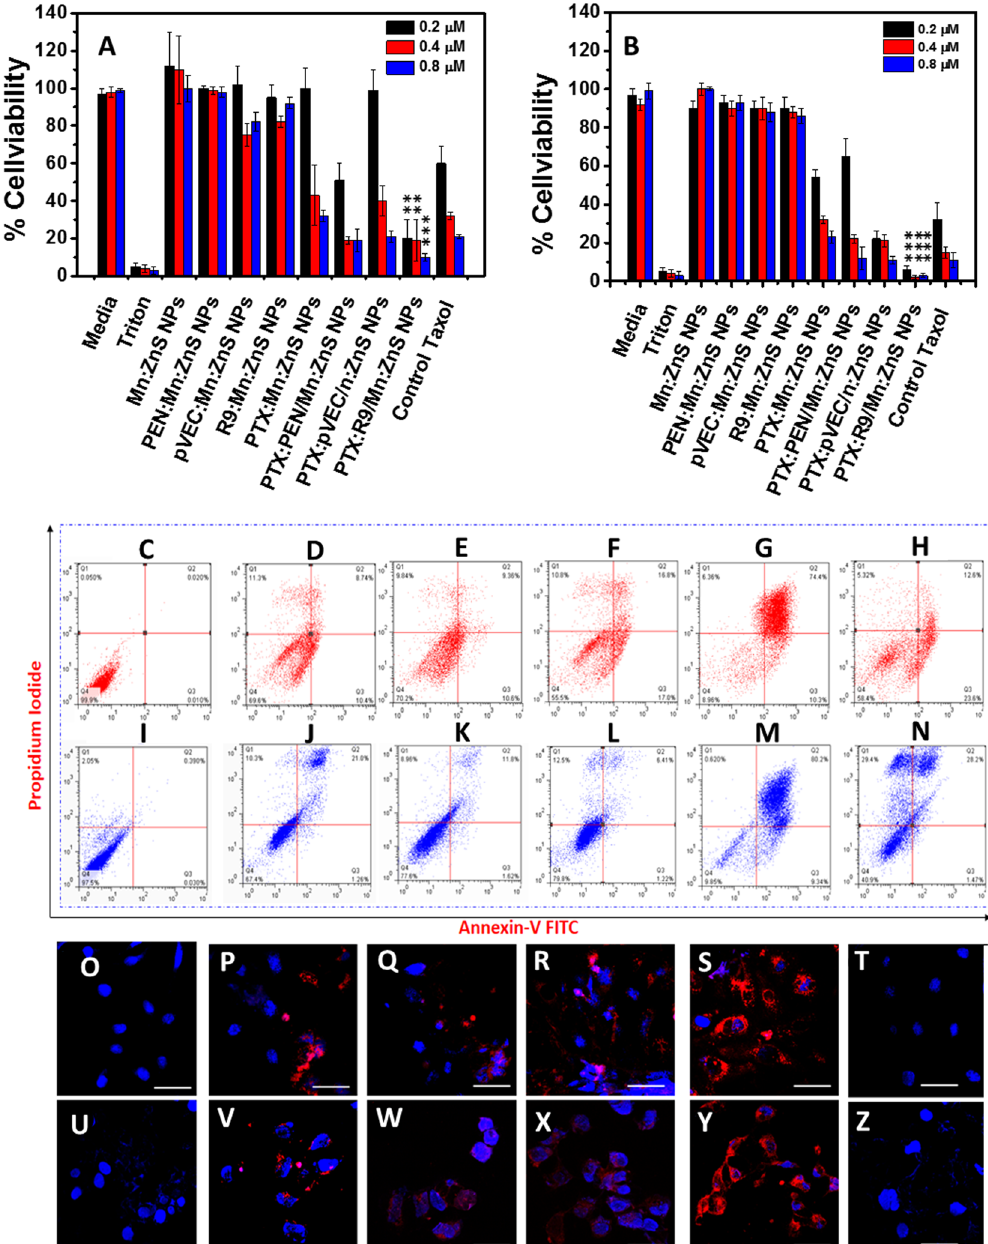
Figure 4. In vitro therapeutic efficacy assessment on ( A ) SKOV-3 and ( B ) HeLa cells by PTX-CPP modified Mn:ZnS NPs after 48 h incubation; The control vehicle concentration is 50, 100, and 200 µ g/mL, whereas the control PTX concentration is 10, 20 and 30 µ M. The actual PTX concentration in samples are 0.2, 0.4 and 0.8 µ M respectively. ( n = 6, ** represents p < 0.01, *** represents p < 0.001) ; ( C – N ) represents the apoptotic profile on SKOV-3 and HeLa cells by the developed PTX formulations with CPP modified Mn:ZnS NPs: ( C ) Control SKOV-3 cells; ( D ) Mn:ZnS NPs; ( E ) PEN/Mn:ZnS NPs; ( F ) pVEC/Mn:ZnS NPs; ( G ) R9/Mn:ZnS NPs and ( H ) Control PTX; ( I ) control HeLa; ( J ) Mn:ZnS NPs; ( K ) PEN/Mn:ZnS NPs; ( L ) pVEC/Mn:ZnS NPs; ( M ) R9/Mn: ZnS NPs and ( N ) Control PTX cells after 48 h incubation time. ( O – Z ) shows the confocal laser scanning electron microscopic images on SKOV3 and HeLa cells: ( O ) control SKOV-3; ( U ) Control HeLa cells; ( P , V ) PTX:Mn:ZnS NPs; ( Q , W ) PTX:PEN/Mn:ZnS NPs; ( R , X ) PTX/pVEC:Mn:ZnS NPs; ( S , Y ) PTX:R9/ Mn:ZnS NPs and ( T , Z ) Control PTX respectively after 48 h incubation time. Blue fluorescence is DAPI staining on the nucleus and red fluorescence indicates the Mn:ZnS NPs (scale bar = 50 µ